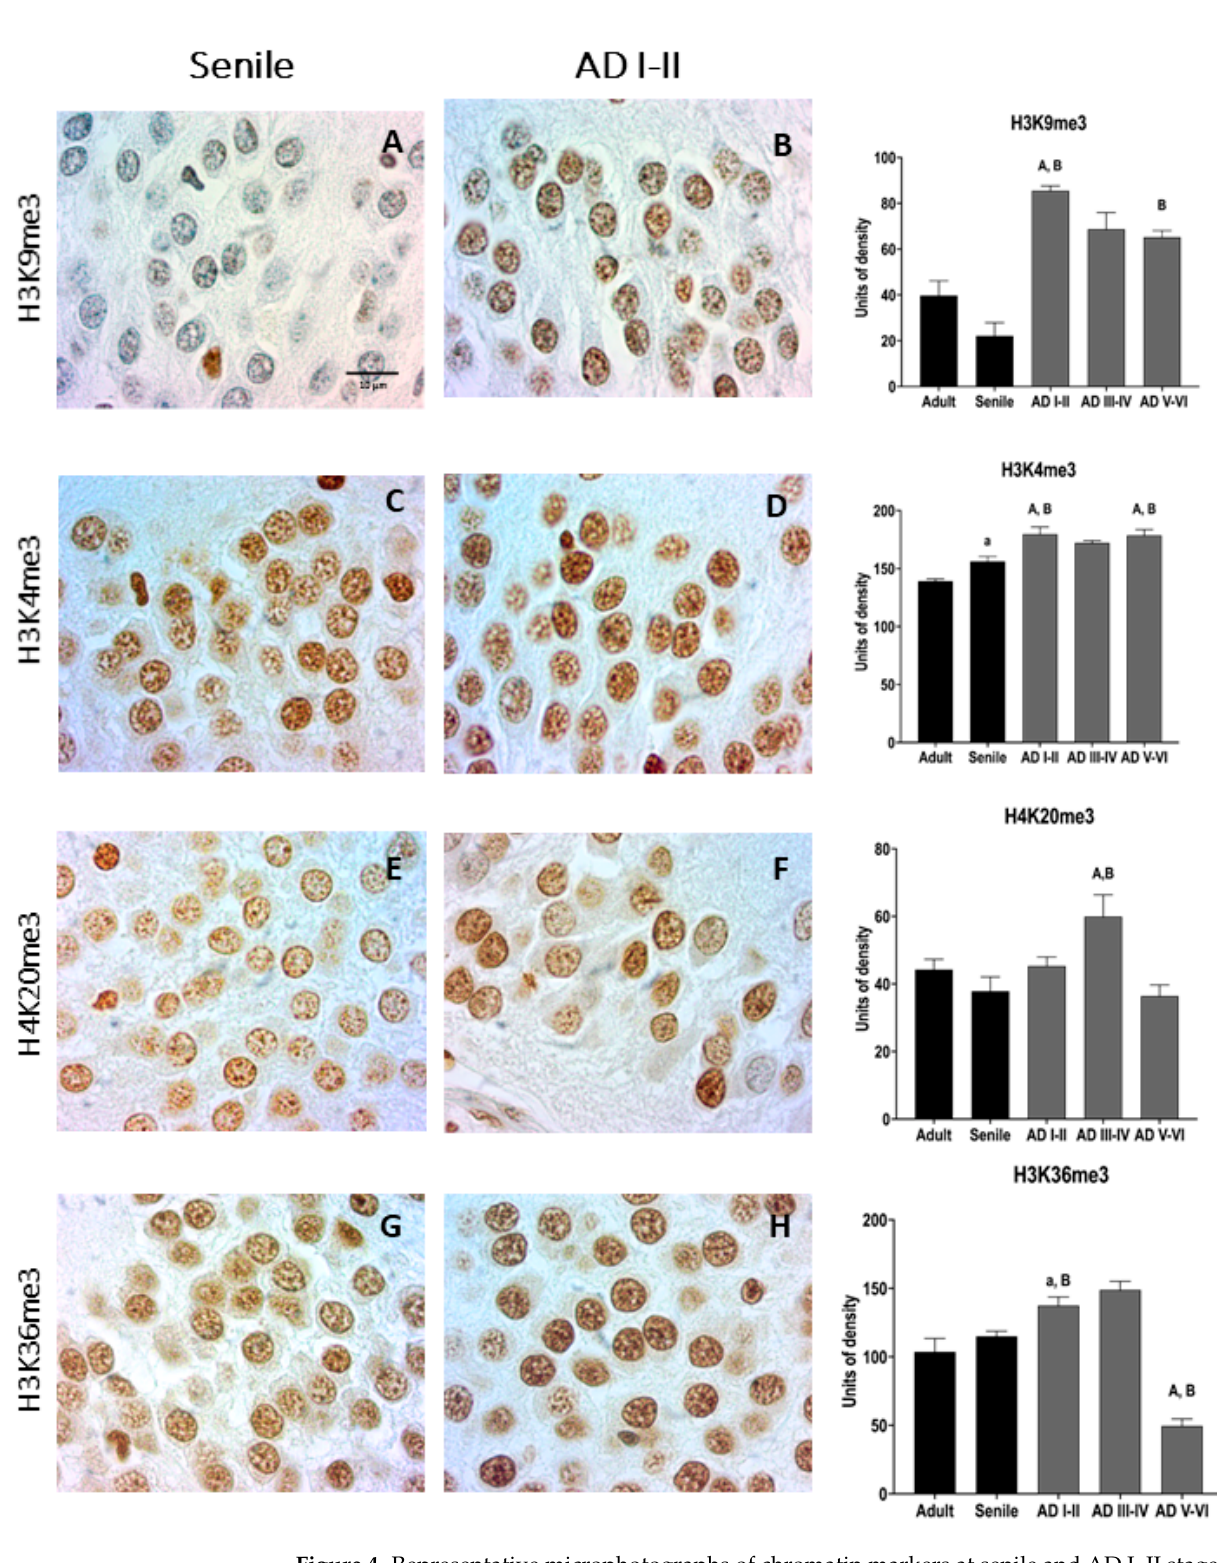
Figure 4. Representative microphotographs of chromatin markers at senile and AD I–II stages. The greatest difference is observed with the H3K9me3 marker ( A , B ). A slight increase is detected with the rest of the markers: H3K4me3 ( C , D ); H4K20me3 ( E , F ) and H3K36me3 ( G , H ). Scale bar: 10 µm. Quantification bars (mean + SD) show statistically significant differences versus adult (( A ), p < 0.001) and senile subjects (( B ), p < 0.001).